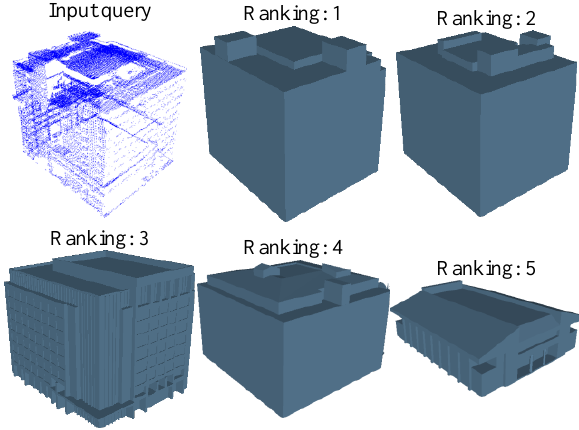
Figure 14. Retrieval results of the proposed method.